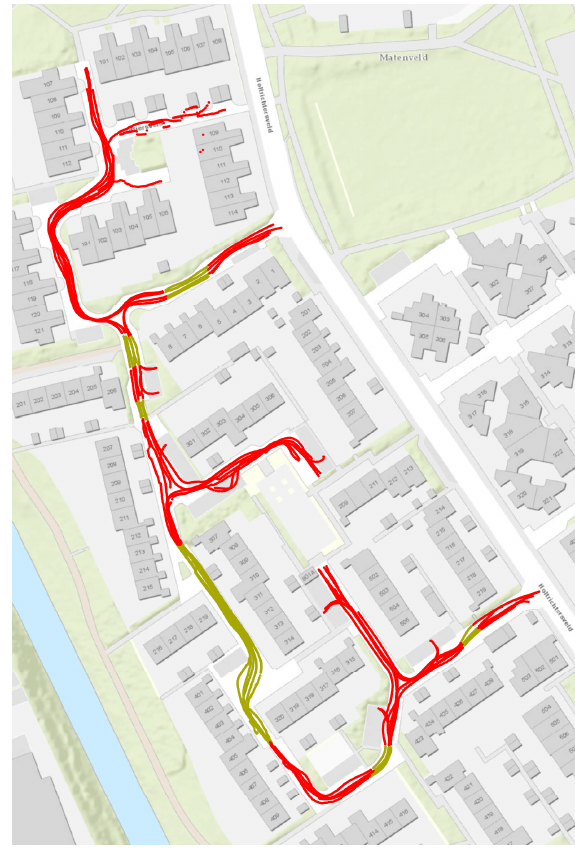
Figure 3. Applied pavement materials (red = con- crete pavers, green = concrete paving